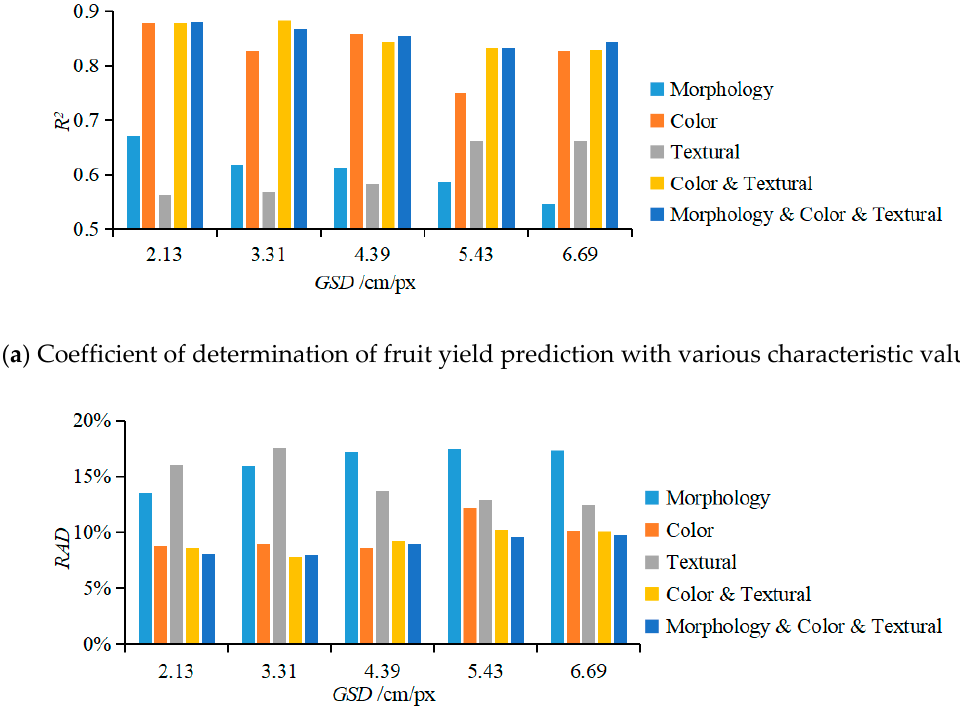
Figure 7. Performance parameters of the fruit yield prediction model with various characteristic values.